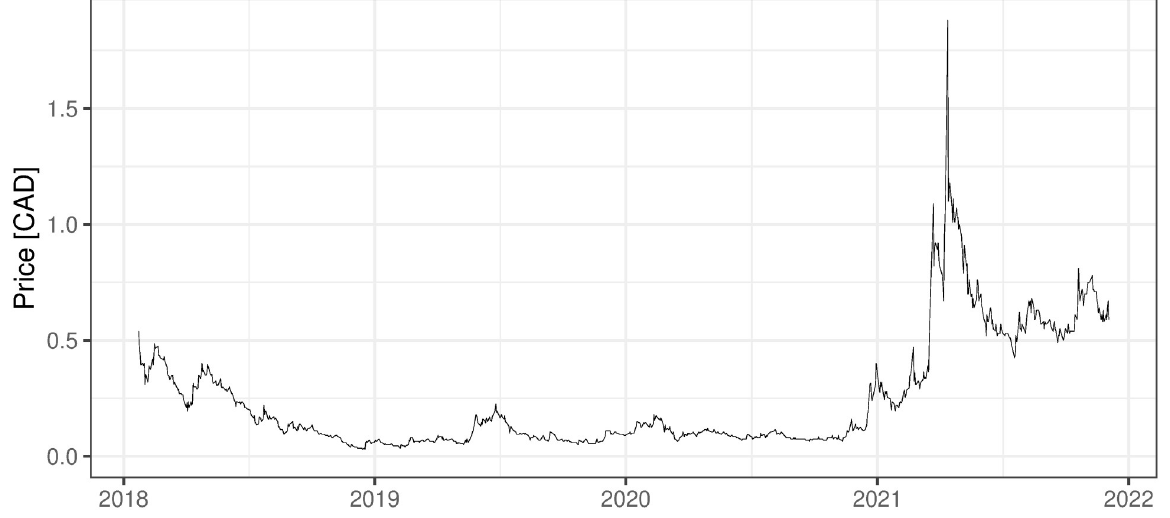
Fig 6. The daily fluctuations of Neptune Dash prices on TSE. Source: https://finance.yahoo.com/chart/NDA.V (downloaded on 2021/12/03).